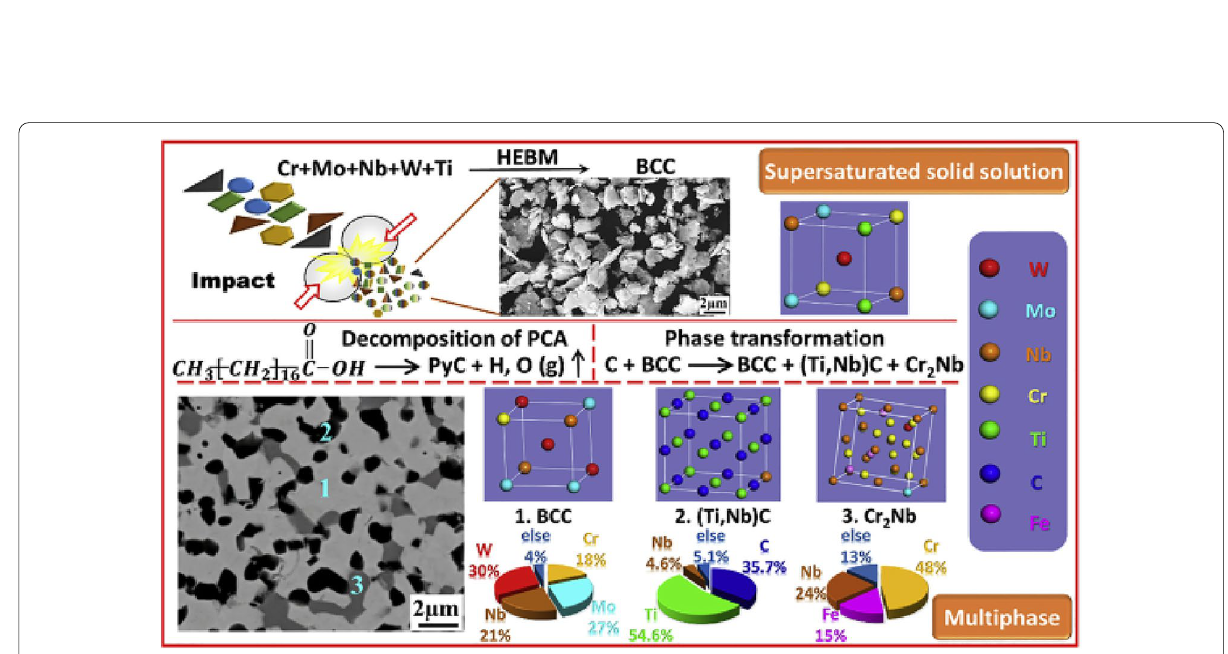
Figure 8 Schematic diagram of the phase evolution during hot-press sintering: The single BCC supersaturated solid solution transformed to multi-phases consisting of BCC, (Ti,Nb)C and Cr 2 Nb. The conceivable crystal structure of each phase was shown by the illustrations of atomic location